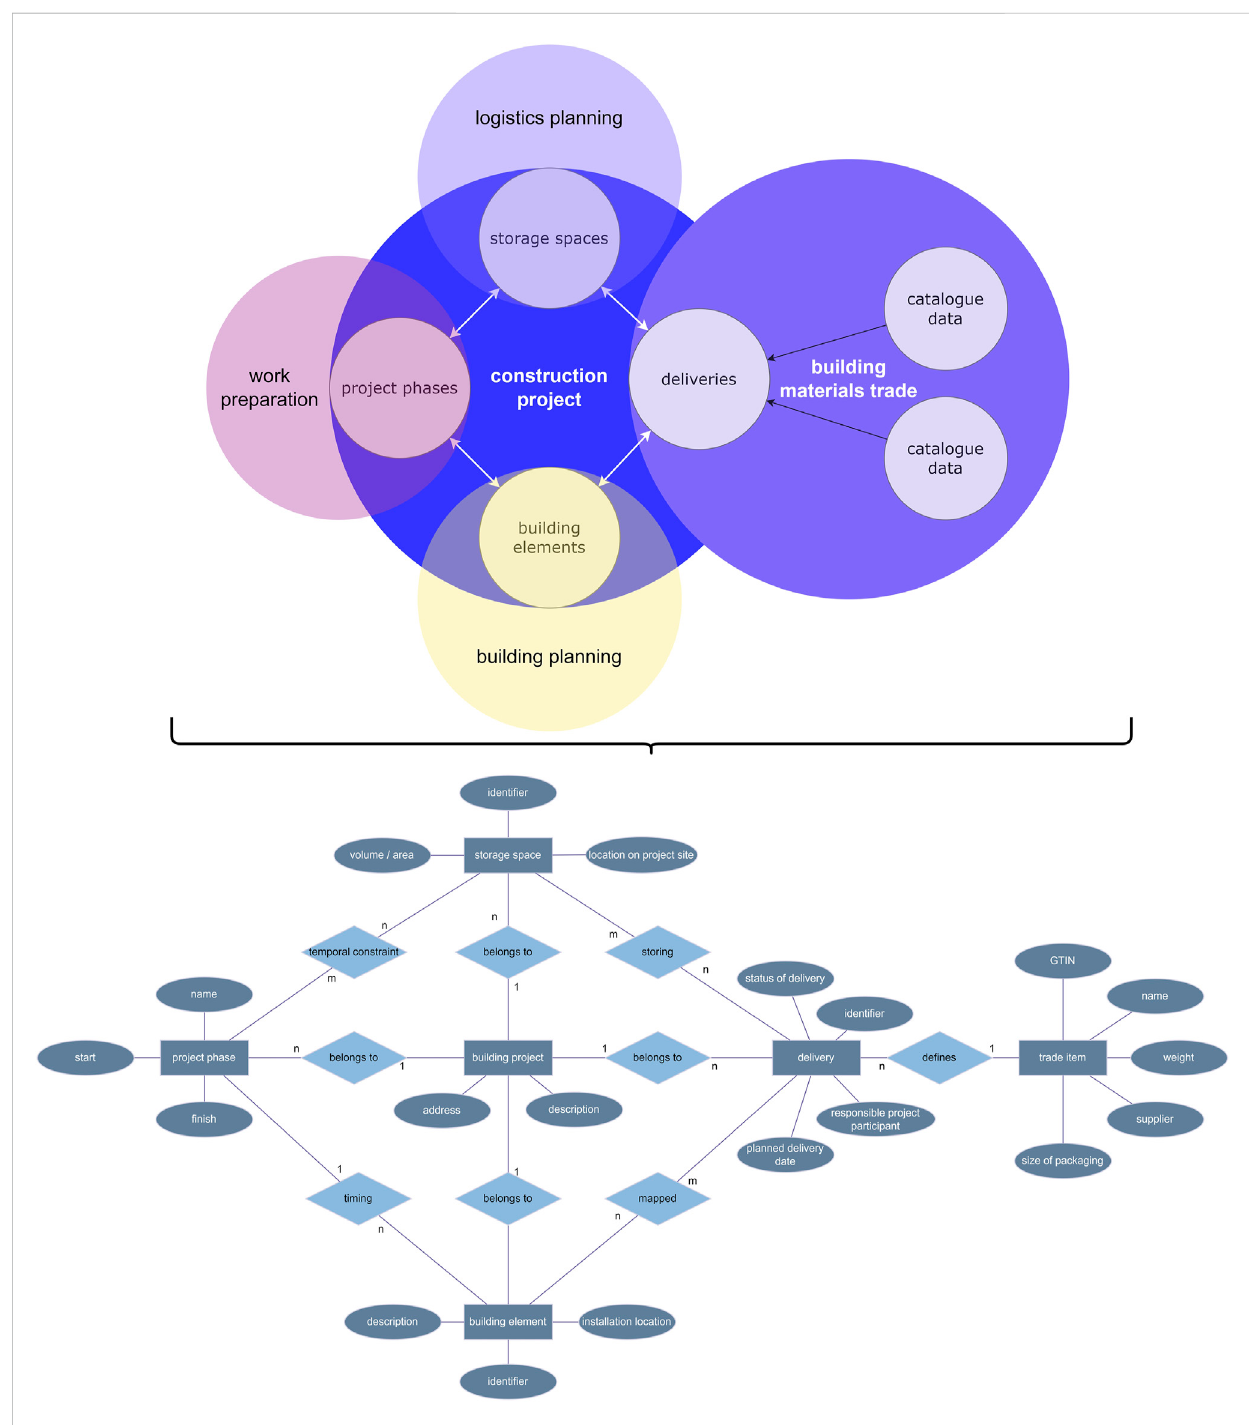
FIGURE 7 Structured data model for the construction logistics